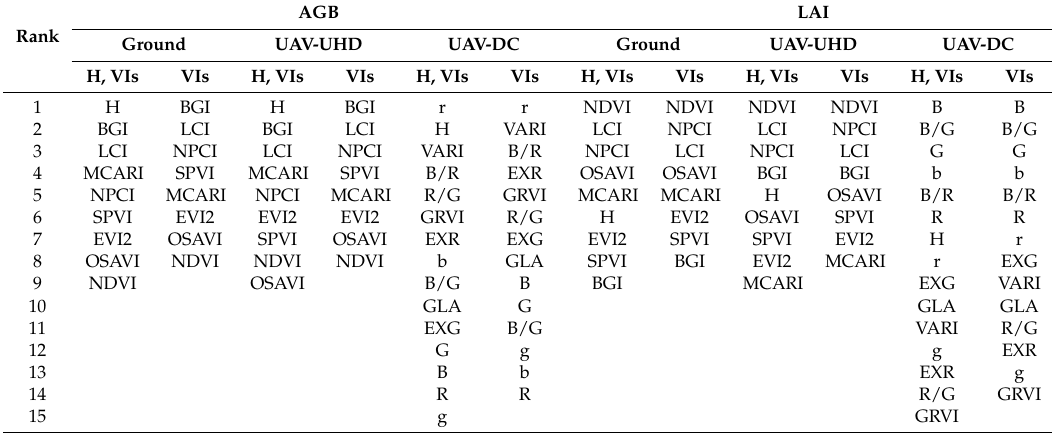
Table A1. Ranking of predictor variables according to its importance in AGB and LAI estimation